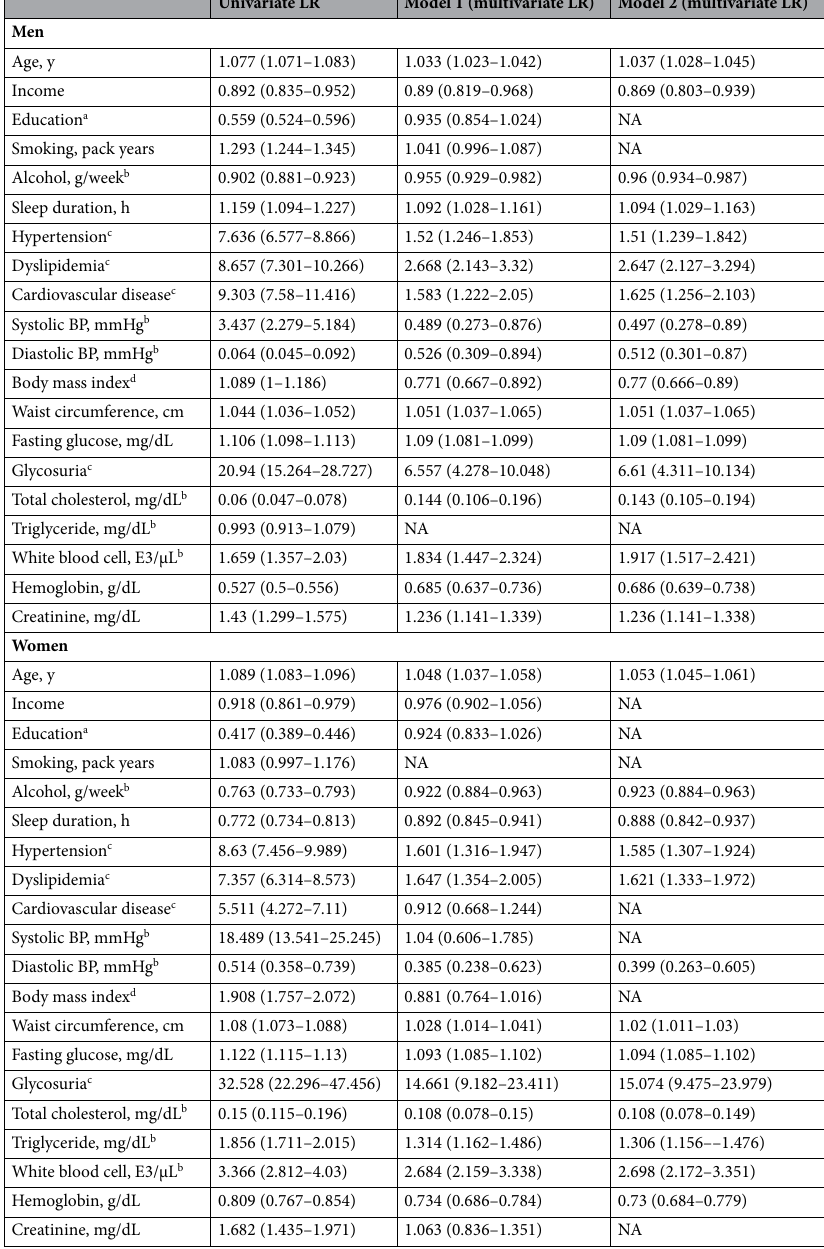
Table 2. Backward stepwise logistic regression of men and women in training set. LR logistic regression. a Elementary (reference: 1)/Middle school (coded as 2)/High school (coded as 3)/College (coded as 4). b The variable is log-transformed. c Absence of status (reference: 0)/Presence of status (coded as 1). d Normal (reference: 1)/Pre-obesity (coded as 2)/Obesity (coded as